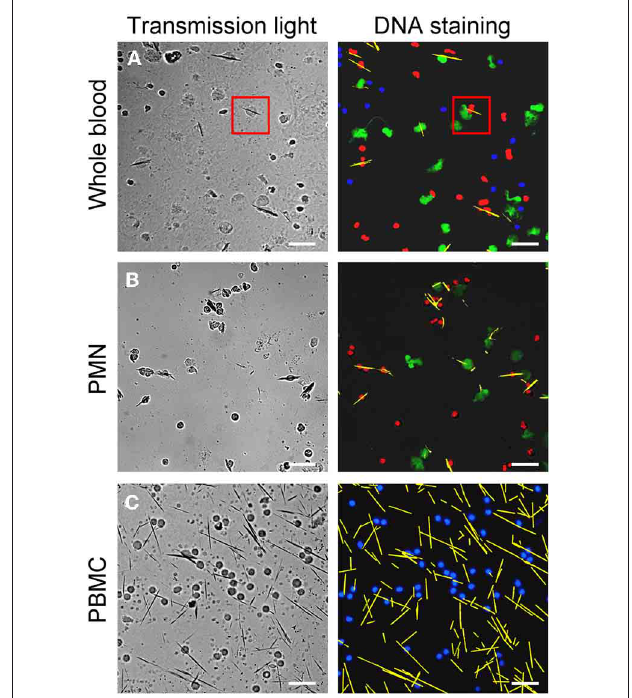
FIGURE 1 | MSU crystals induce NET formation in PMN but not in PBMC. Whole blood cells (A), isolated PMN (B) and isolated PBMC (C) were incubated with MSU crystals. Cytospins were prepared and stained for nuclear and extranuclear DNA. The transmission microscopy (left) shows phagocytes which have ingested MSU crystals. The DNA staining (right) shows NETting granulocytes in whole blood cells ( A , red square) and isolated PMN (B) . No MSU-induced extracellular DNA was observed in isolated PBMC (C) . In (A) and (B) erythrocytes and free MSU crystals were dissolved by acid treatment. (A–C) NETs were artificial colored in green, PMN in red, mononuclear cells in blue and MSU crystals in yellow. All experiments were performed at least 3 times. Scale bars,100 μ